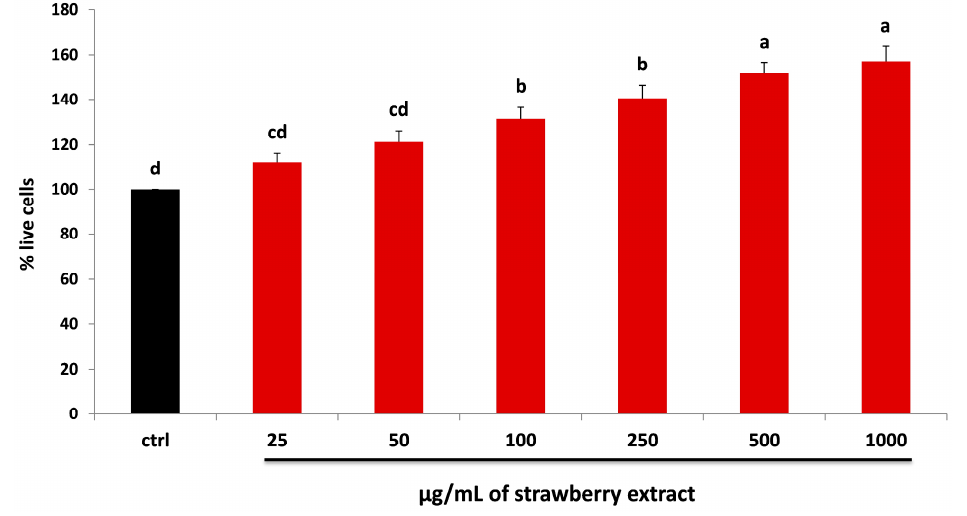
Figure 1. MTT assay for the determination of cell viability in HDF cells treated with different concentrations of strawberry extracts (25–1000 µg/mL) for 24 h (red bars). Black bar represents the control group. Data are expressed as mean values ± standard deviation (SD). Values with different superscript letters are significantly different ( p < 0.05).